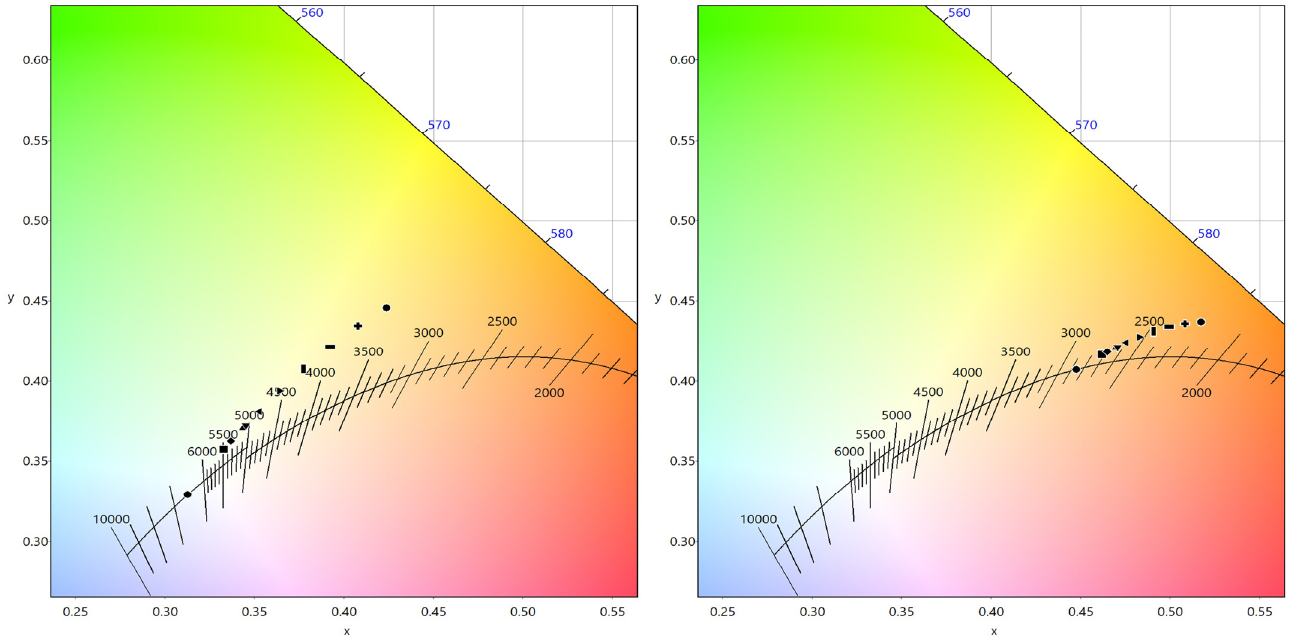
Figure 4. Chromatic diagram representing the location of the D65 and A standard illuminants by optical density and age, from 10- to 90-year-old observers. Left : D65 illuminant. Right : A illuminant. Table 2. Changes in circadian lighting (EDI and EML) for D65 and A illuminants reaching the retinal plane depending on the age of the subjects, considering 200 photopic lux at the corneal plane. Calculations without age considerations match with a standard observed age of 32, as described in the current normative. Abbreviations: MAF trans , Melanopic Action Factor considering transmittance of the lens; EDI, Equivalent Daylight Illuminance; EML, Equivalent Melanopic